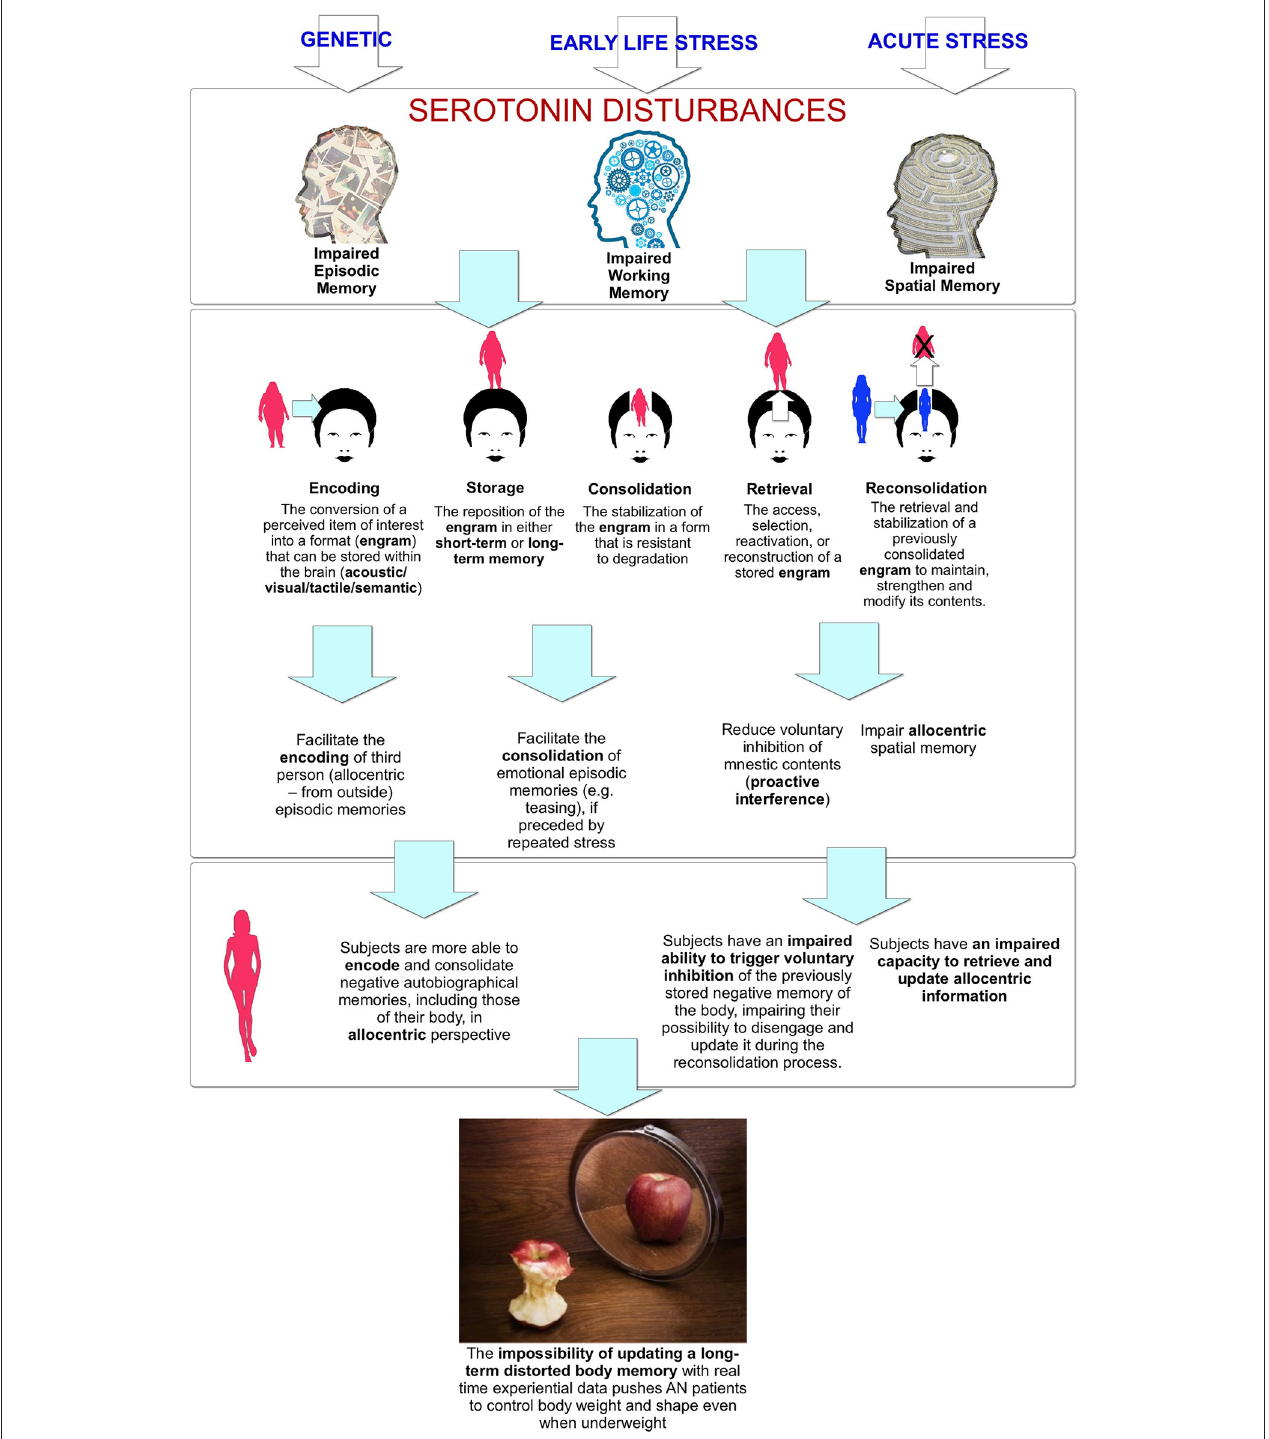
FIGURE 2 | The link between serotonin disturbances and body memory impairments.